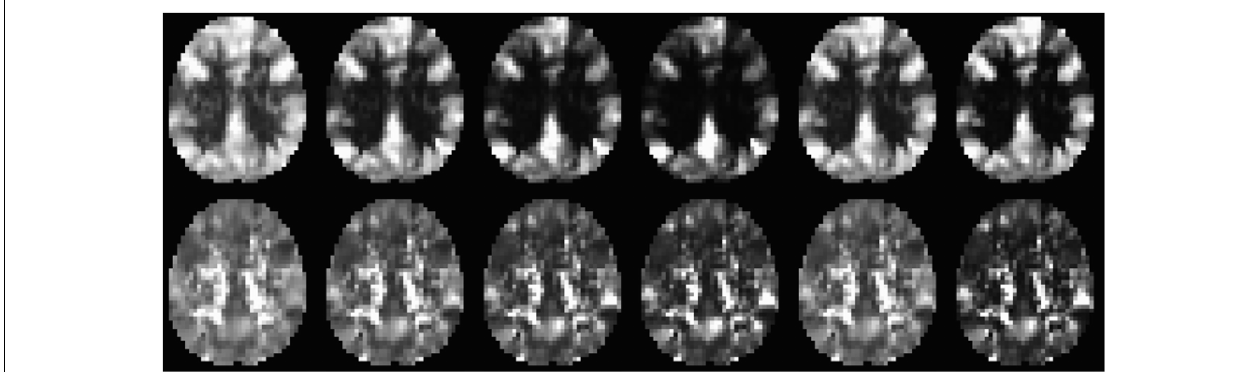
FIGURE 4 | An axial slice of the CDI P (upper row) and CDI N (lower row) metrics derived from a typical R-fMRI dataset (a male subject of 36 year’s age). The images from left to right depict the results for the following 6 kernel functions | x|, | x 2 |, | x 3 |, | x 4 |, sin 2 ( π /2x), and step(| x| − 0.3), respectively.